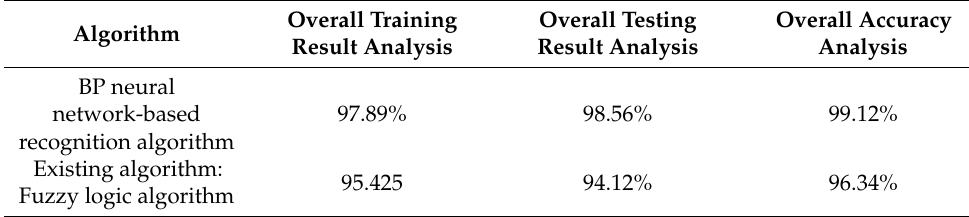
Table 2. Overall result analysis for the existing